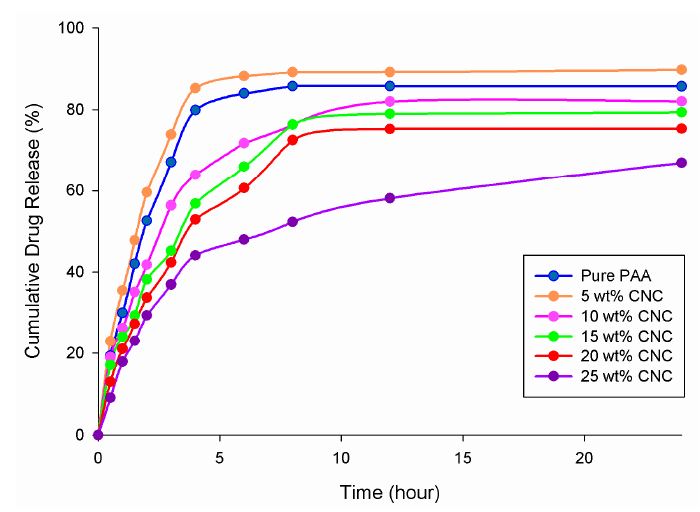
Figure 8. Cumulative drug release of hydrogels with varying CNC compositions.